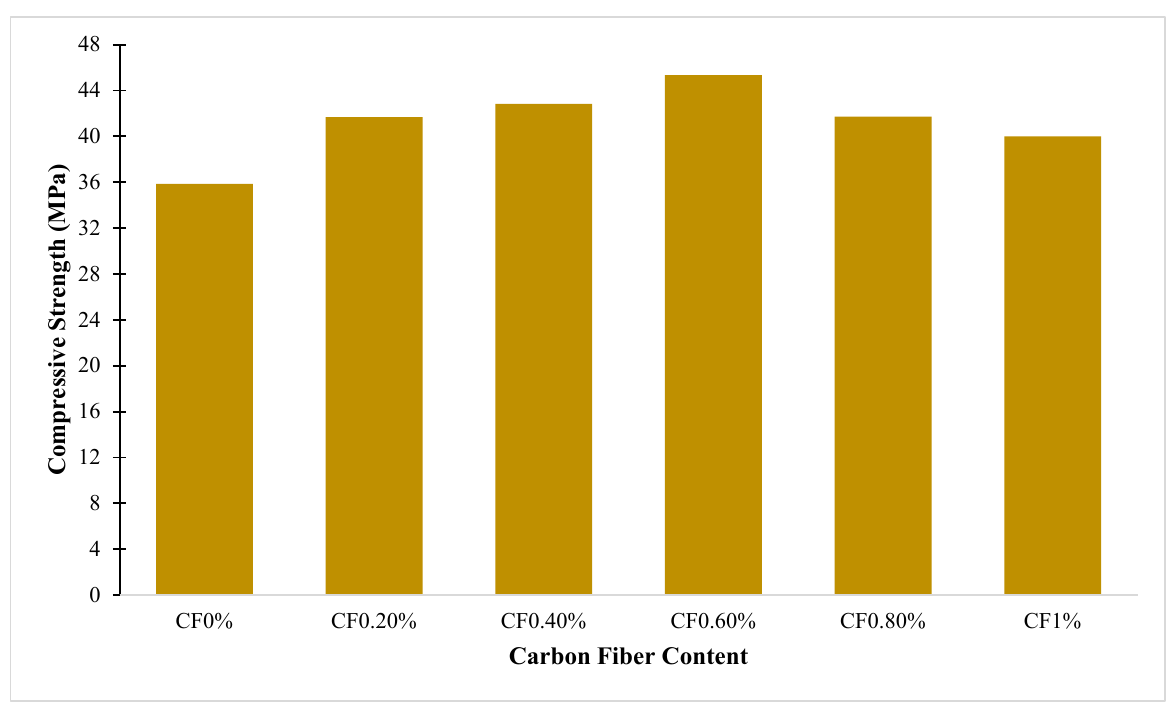
Figure 4. Compressive strength laboratory testing.